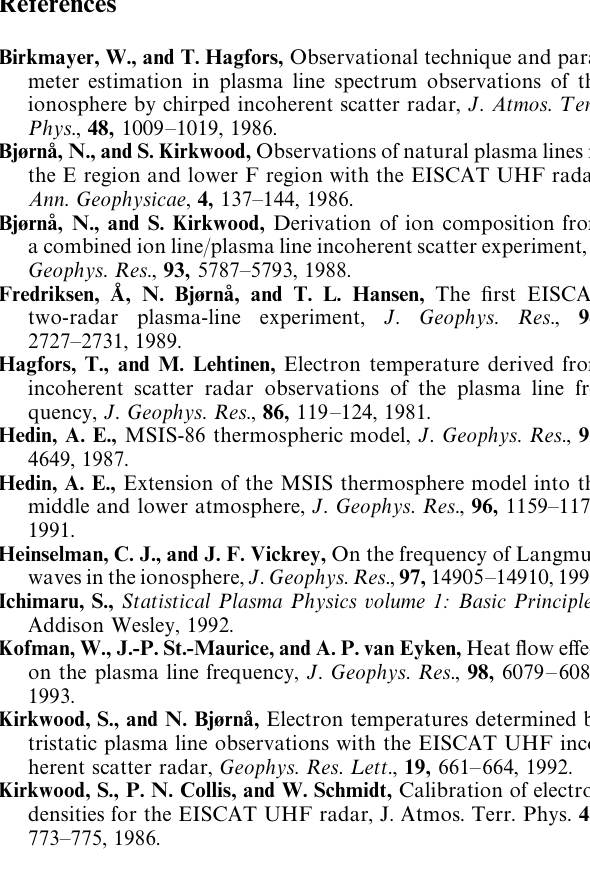
Fig. 8. Predicted plasma line strength for the EISCAT Svalbard radar for daytime and auroral conditions and three different alti- tudes. The left y - axis gives the plasma line temperature in eV, the right y - axis the F-region (250 km) signal-to-noise ratio for typical